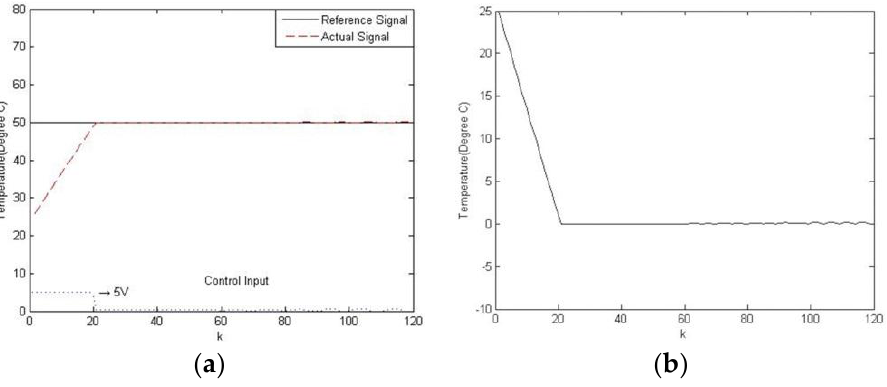
Figure 26. ( a ) Outputs and ( b ) errors of the FNFN controller with the plant dynamics altered in the water bath system.